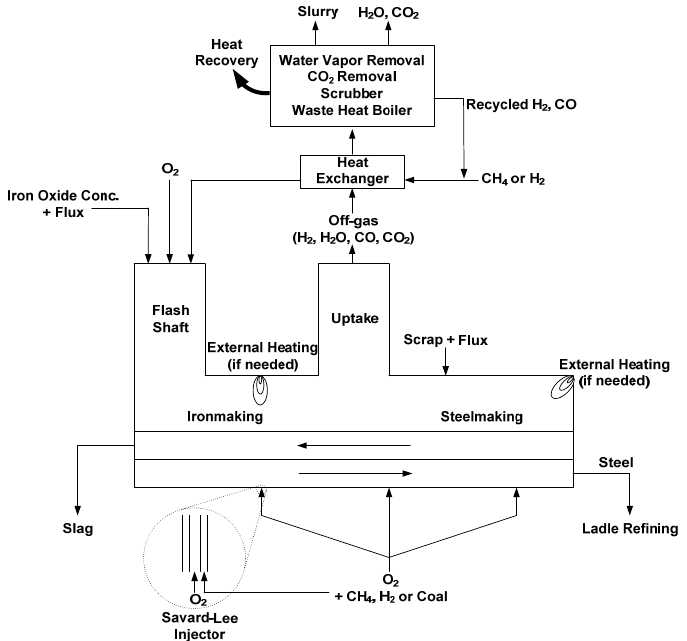
Figure 1. A schematic diagram of a possible direct steelmaking process based on flash ironmaking technology (FIT).